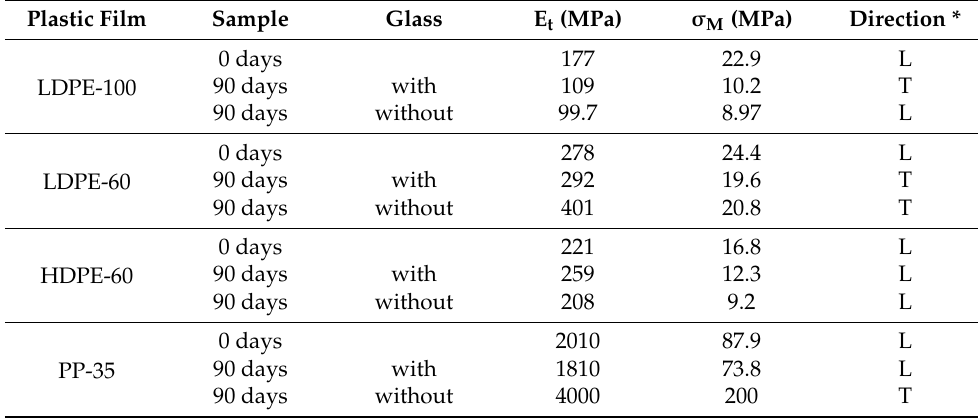
Table 5. Young’s modulus and maximum tensile strength data for aging